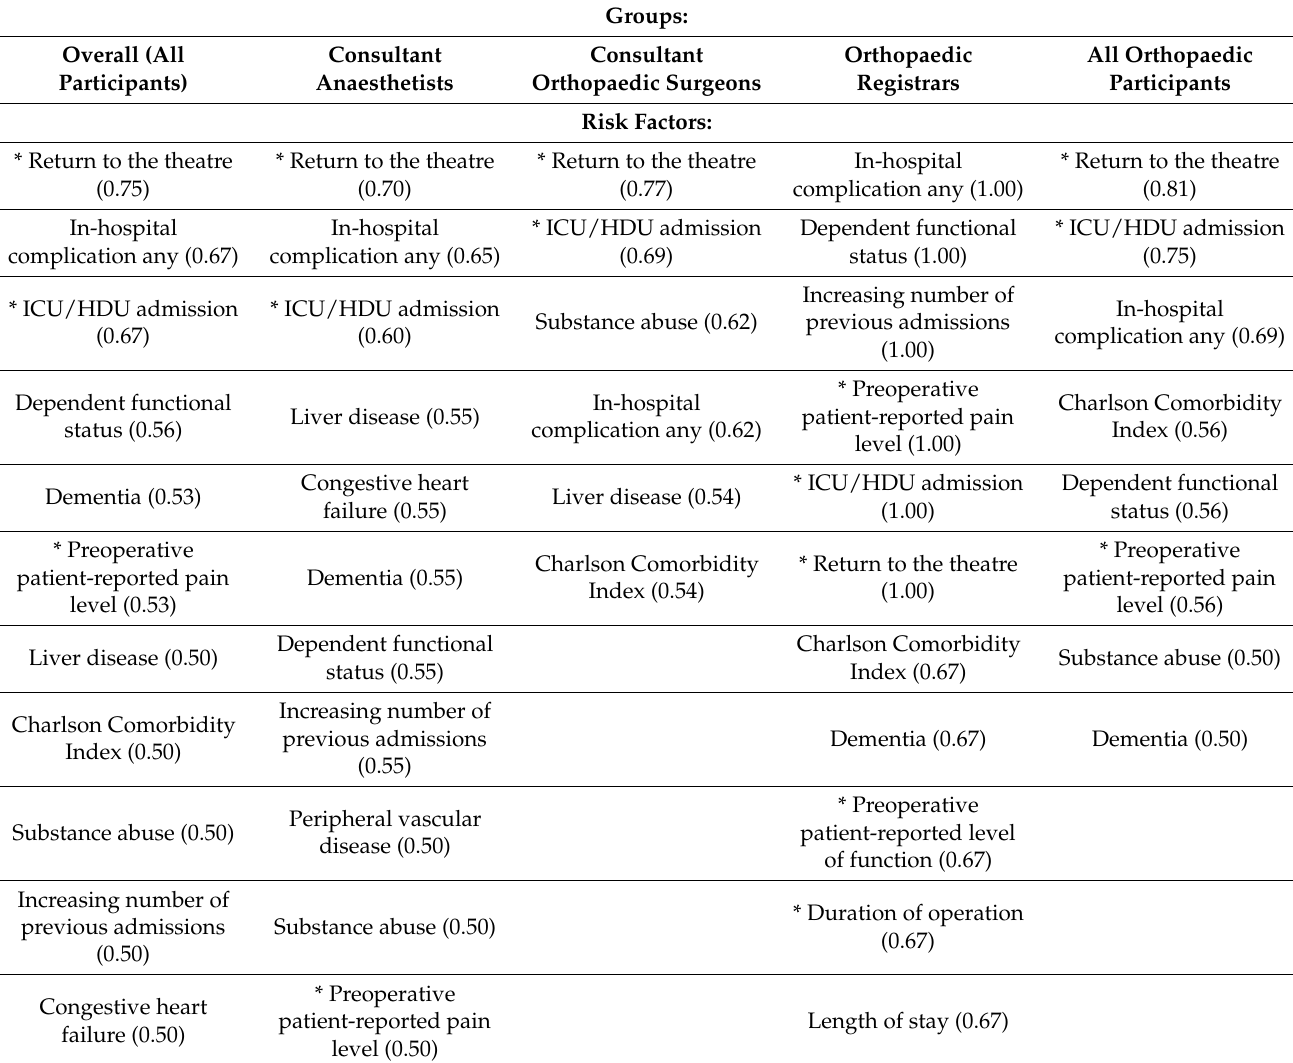
Table 2. Delphi survey risk factors with a majority vote of high importance.